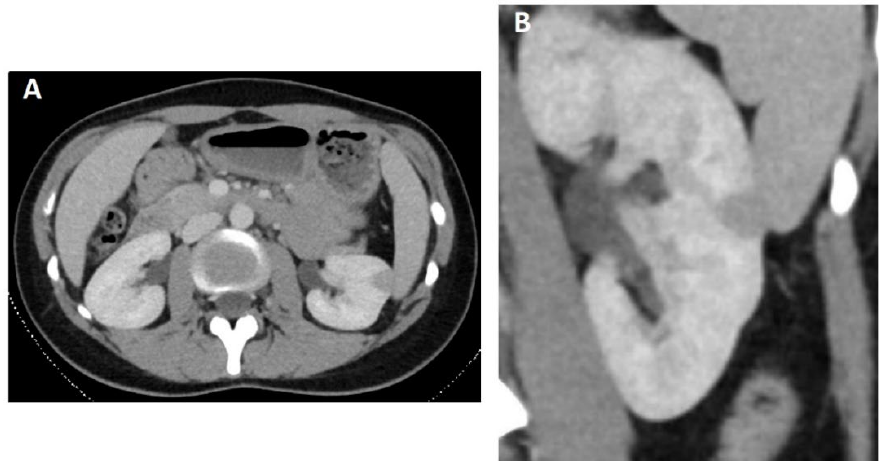
Figure 1. Enhanced CT in axial ( A ) and coronal ( B ) plane show a well-defined bulging mass in the midportion of the left kidney with an almost homogeneous and hypodense characteristic compared to the renal cortex in portal venous phase.